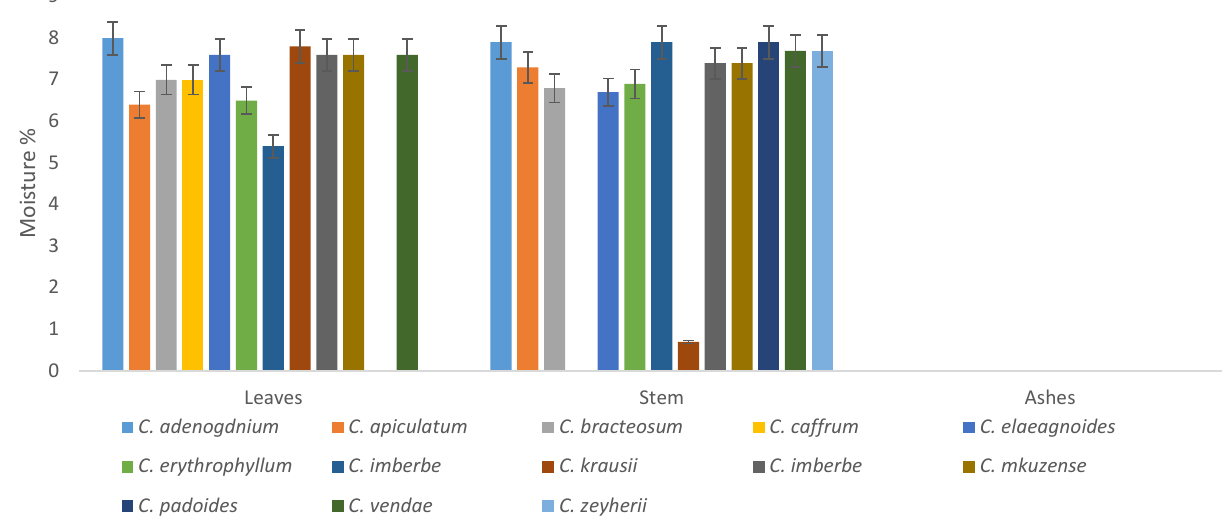
Moisture content of the plants ranged from 0–9% in both the ash, leaves, and stems. The leaves of C. vendae and C. adenogonium had no moisture; it was only detected in the stems. The leaves of C. caffrum had the highest moisture content, however; the stems had 0% of moisture content, as depicted in Figure 8.